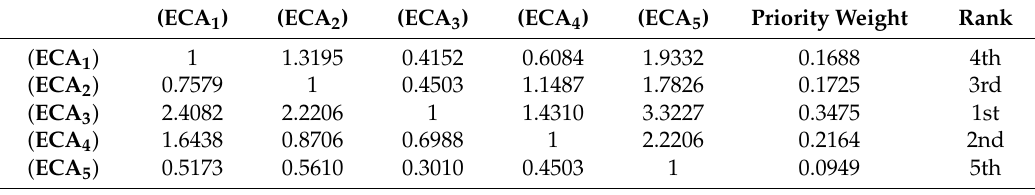
Table A4. Pair-wise comparison matrix of economic